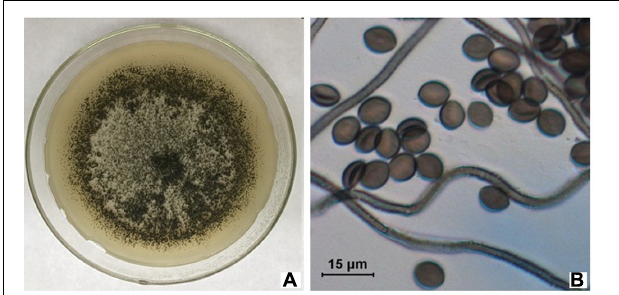
FIGURE 1 | Morphological characteristics and microstructure of D38. (A) D38 Colony in PDA; (B) Micrograph of